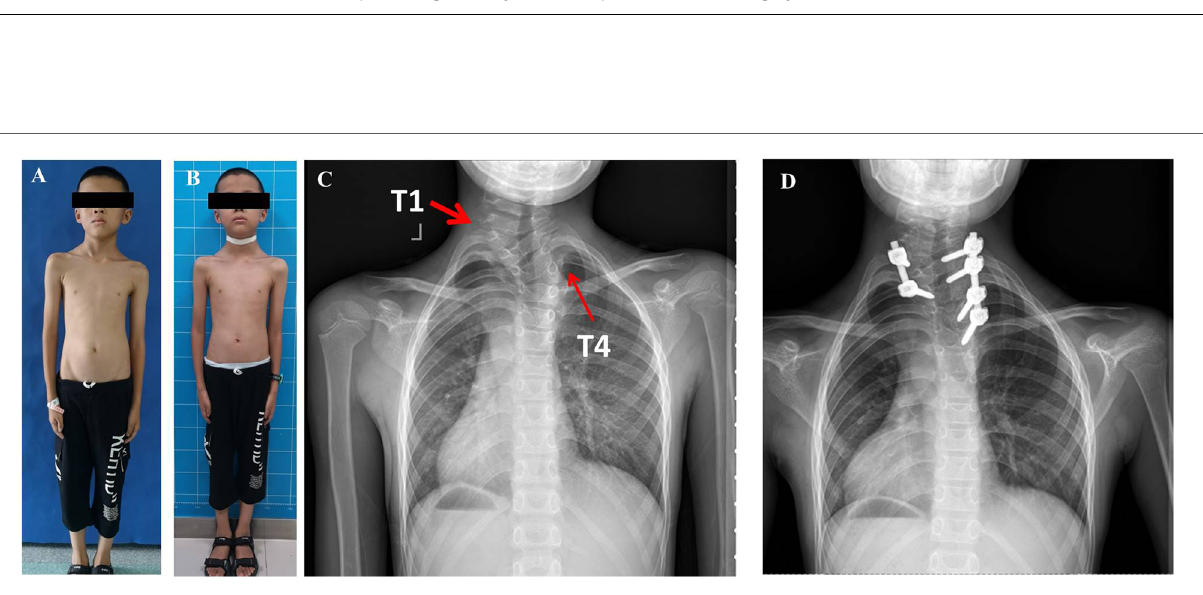
FIGURE 2 A 6 years 3 months old boy presented shoulder imbalance and facial asymmetry. Radiographs indicated that T2 and T10 were both hemivertebra and they compensated each other before the operation ( A,D ). He underwent a staged operation. The T10 HV was removed at the fi rst surgery and he gained good shoulder balance and worsening torticollis due to the lack of compensatory T10 HV 3 months post the fi rst operation ( B,E ). T2 HV was resected a second time, and his facial cosmesis and torticollis improved signi fi cantly 3 months post the second surgery ( C,F ).